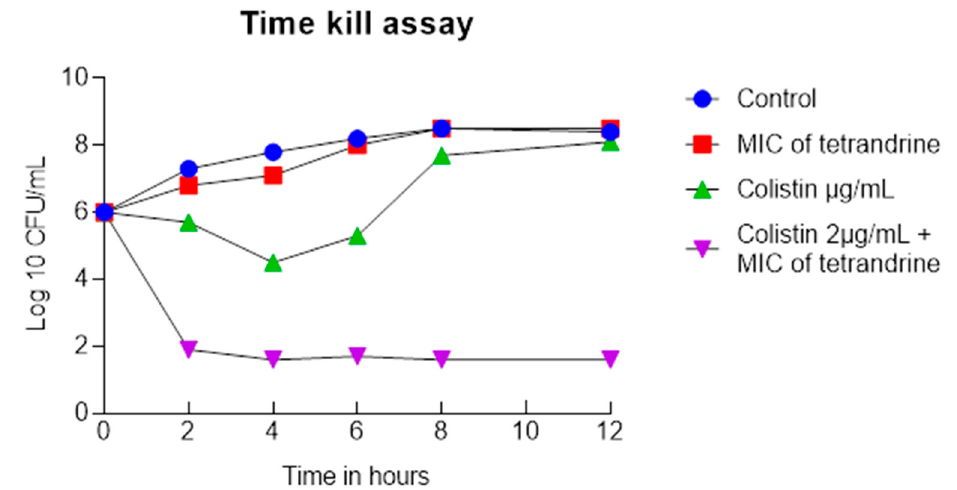
Figure 1. Colistin and tetrandrine in combination inhibits the growth of colistin-resistant E. coli . Time kill assay of colistin and tetrandrine alone and in combination shows that neither colistin nor tetrandrine inhibits the growth of E. coli . In contrast, the growth of E. coli was significantly reduced when treated with a combination of colistin and tetrandrine.